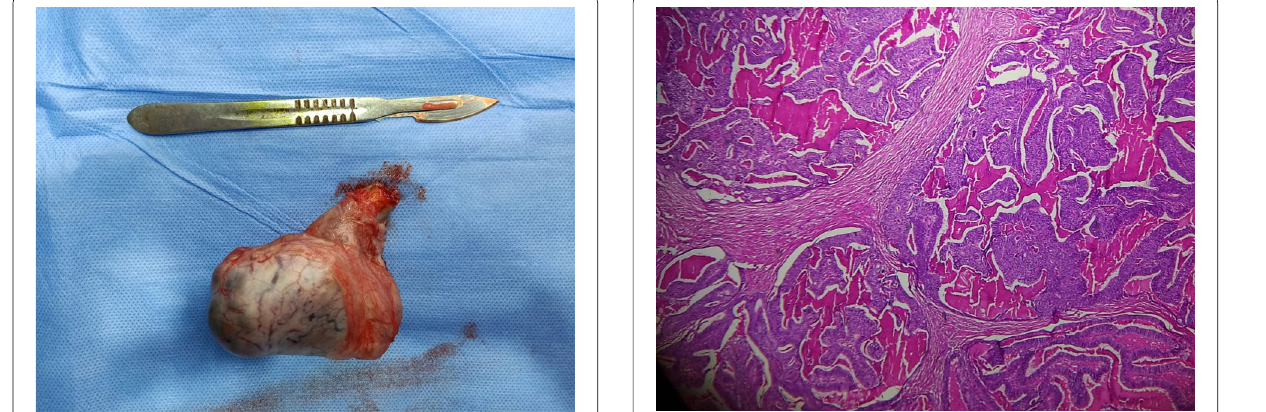
Fig. 3 Tumor proliferation of tubular and papillary architecture